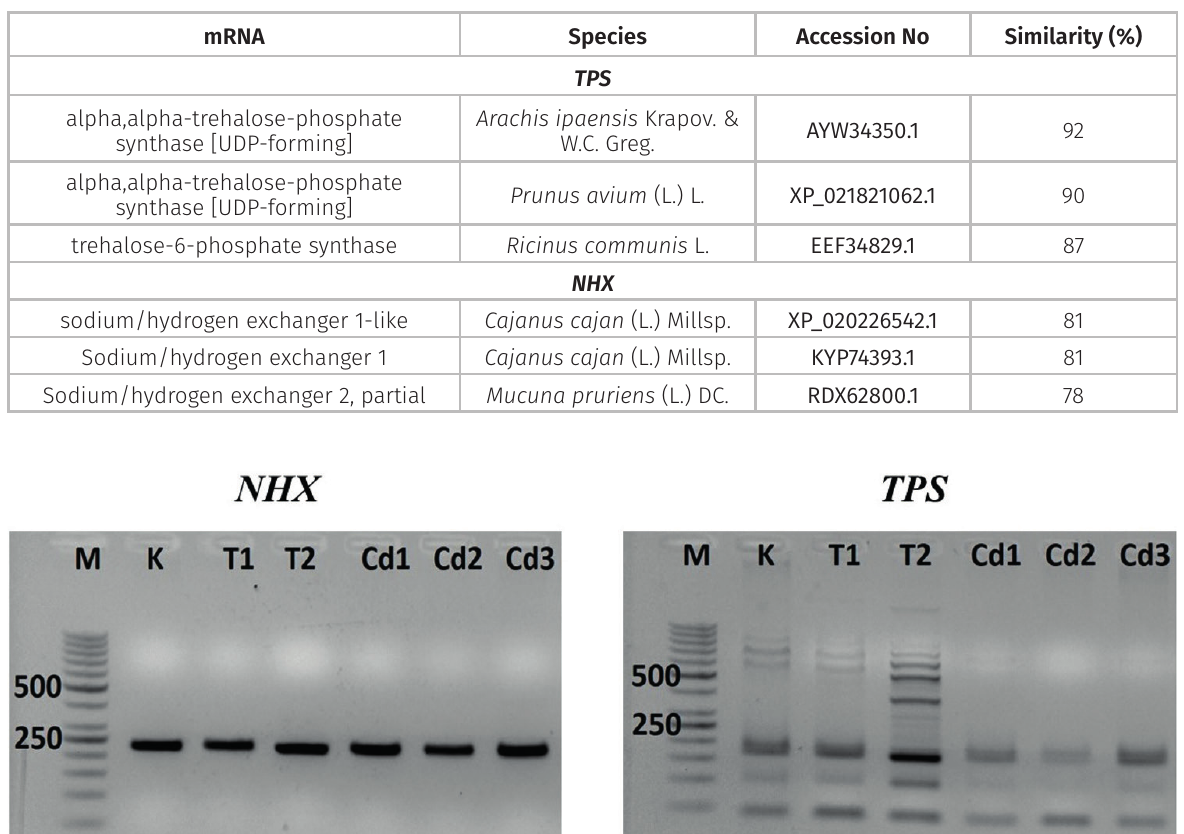
Table III. Sequence similarities according to The BLAST search against NCBI database based on identifi ed partial sequences in V. turcica